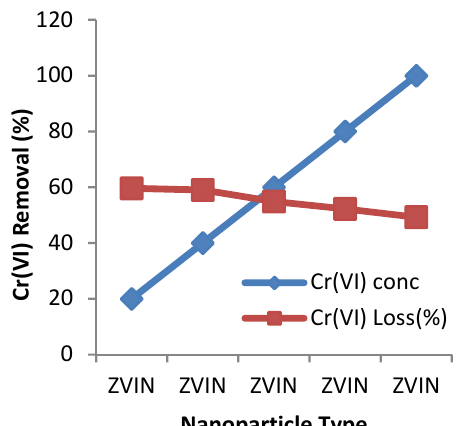
Fig.9.The removal efficiency of Cr(VI) using PAM- ZVINs as afunction of Cr(VI) concentrations